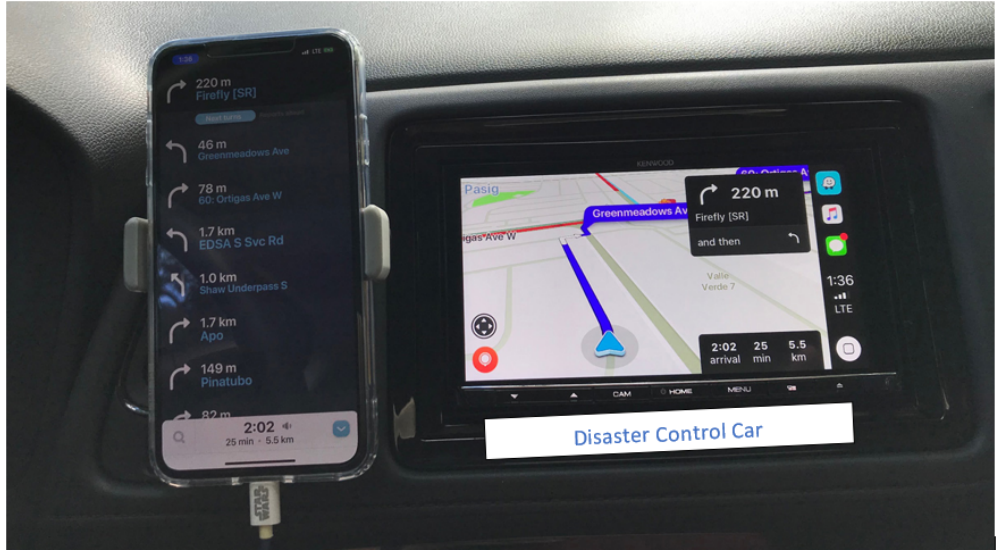
Figure 15. The demonstration of the proposed system with the output sent to a vehicle control information system